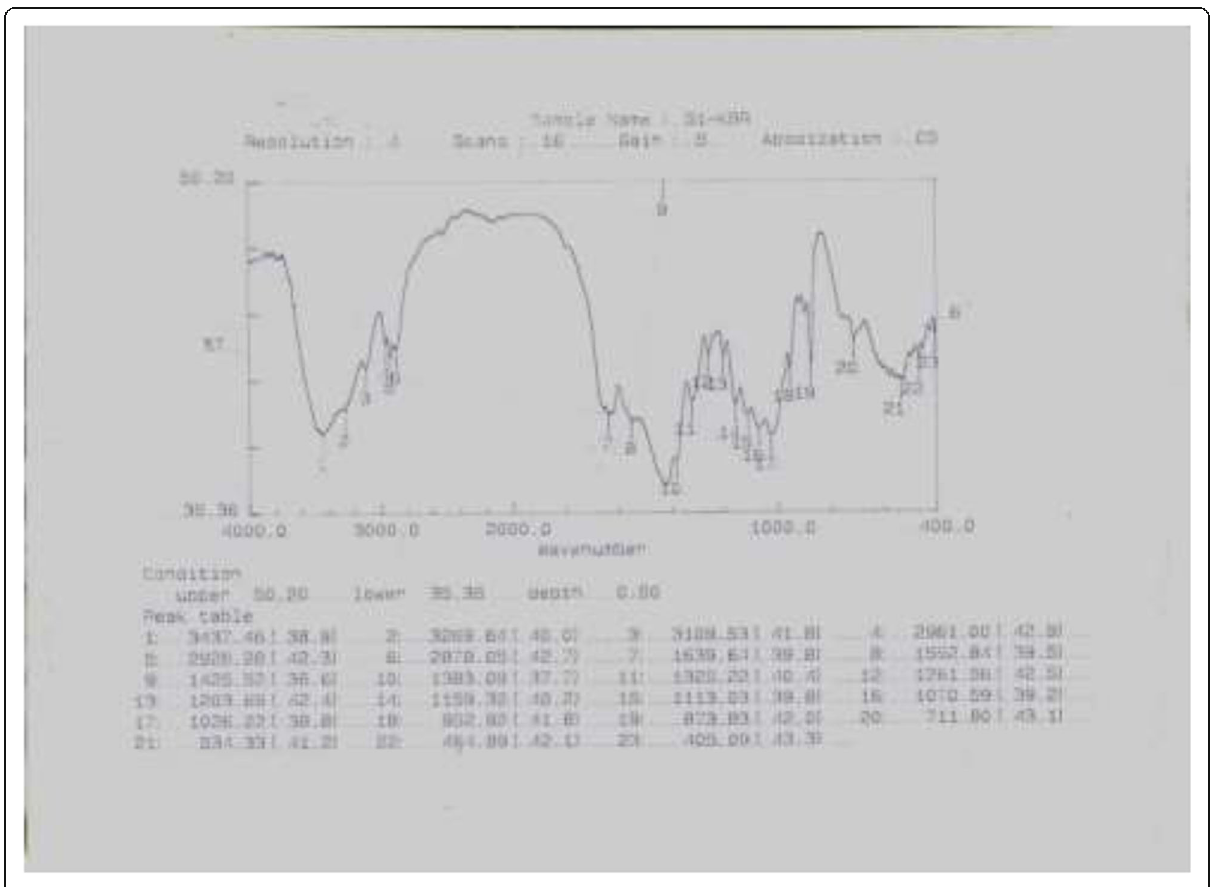
Fig. 2 FT-IR spectra of chitin extracted from Millipede